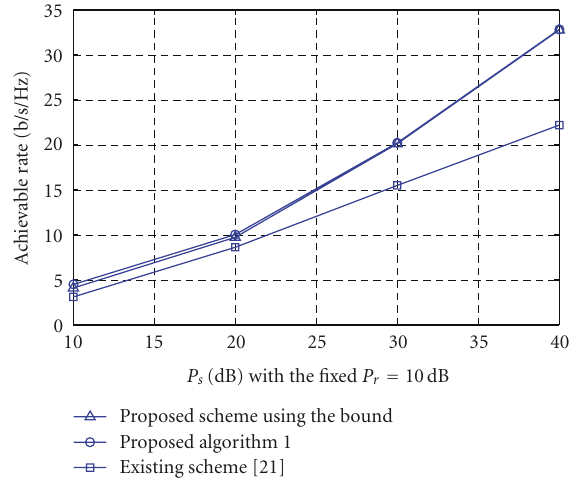
Figure 3: Achievable rate comparison for the lattice-based physical- layer network coding when K = 2.